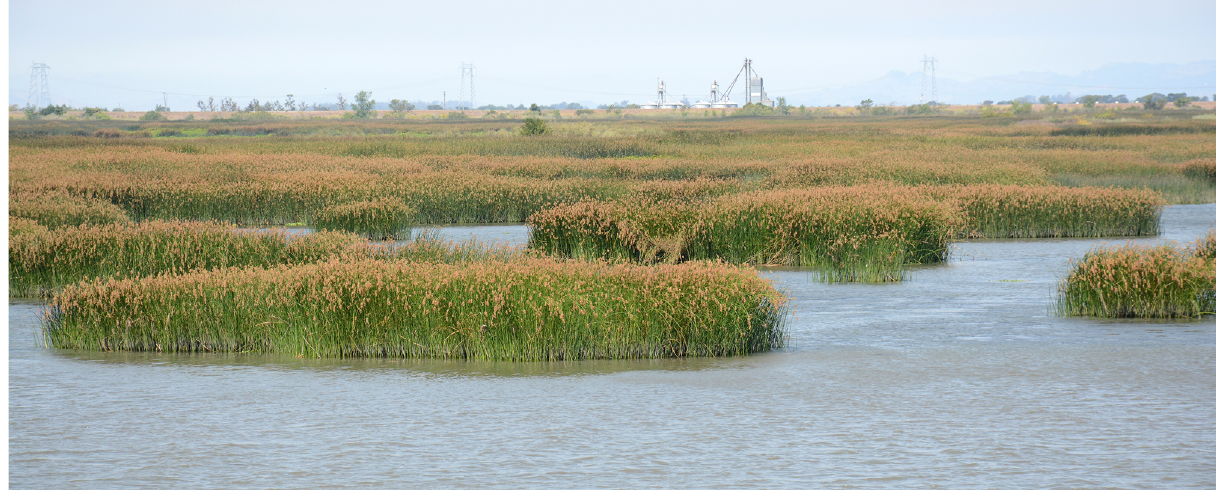
Figure 4. Ground view of tidal marsh formation on what was formerly the Liberty Island Tract, 2015. Prior to a final levee breach in 1997, all of this naturalized landscape was farmland. Image by Brett